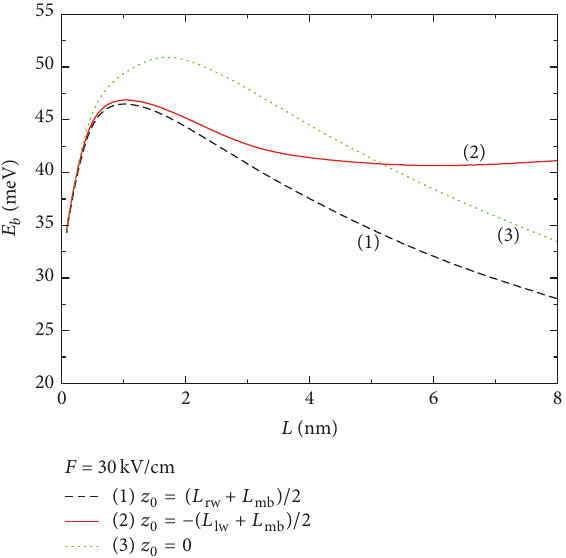
Figure 2: The ground-state donor binding energy 𝐸 𝑏 in a ZB In 𝑥 Ga 1−𝑥 N/GaN symmetric coupled QDs as a function of the dot radius R with 𝐿 lw = 5 nm, 𝐿 mb = 1 nm, 𝐿 rw = 5 nm, 𝜌 0 = 0 . In these calculations were considered three values of the applied electric field—zero (curve 1), 𝐹 = 30 kV/cm (curve 2), and 𝐹 = 50 kV/cm (curve 3).